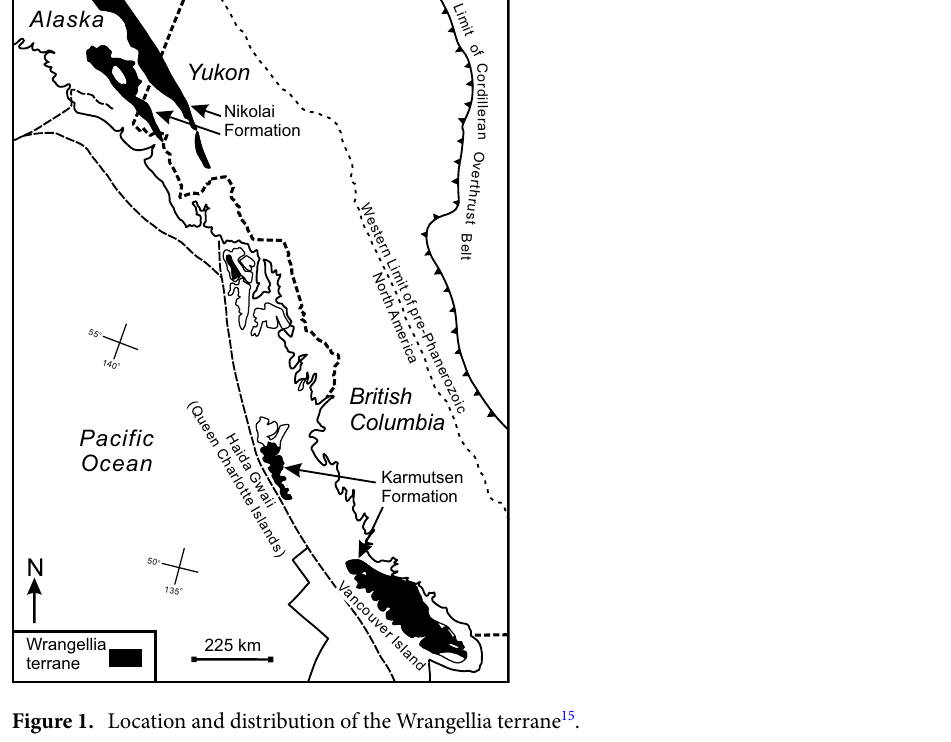
Figure 1. Location and distribution of the Wrangellia terrane 15